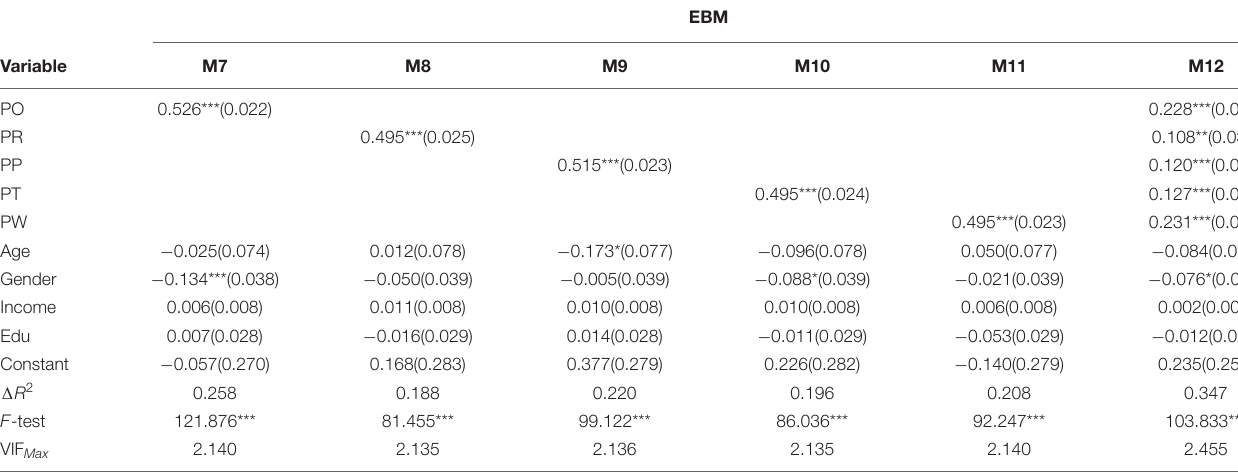
TABLE 3 | Consumer purchase behavior changes and efficiency-centered business model